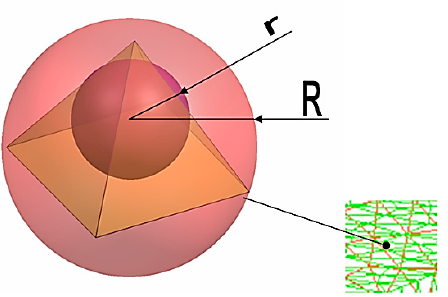
Figure 20. Illustration showing the idea of the aspect ratio of a computational cell.